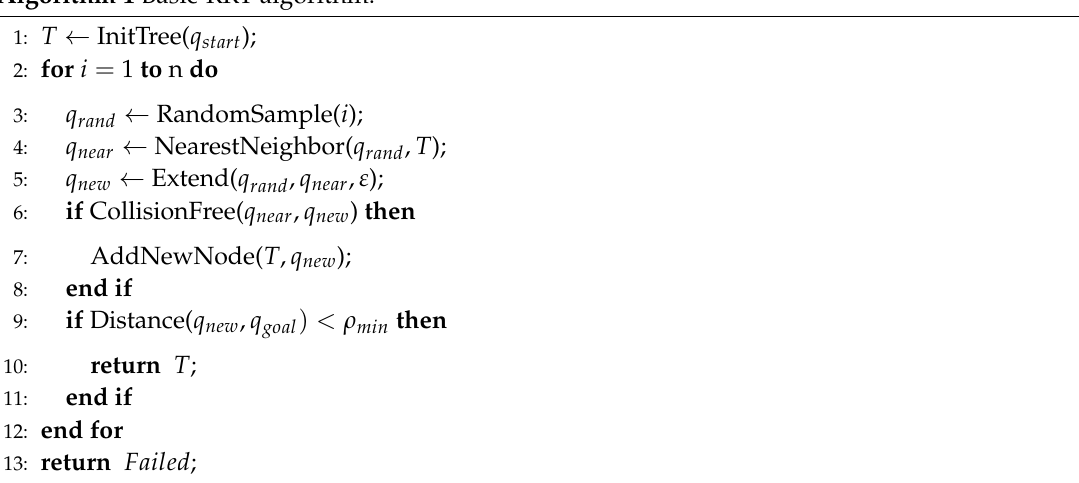
Algorithm 1 Basic-RRT